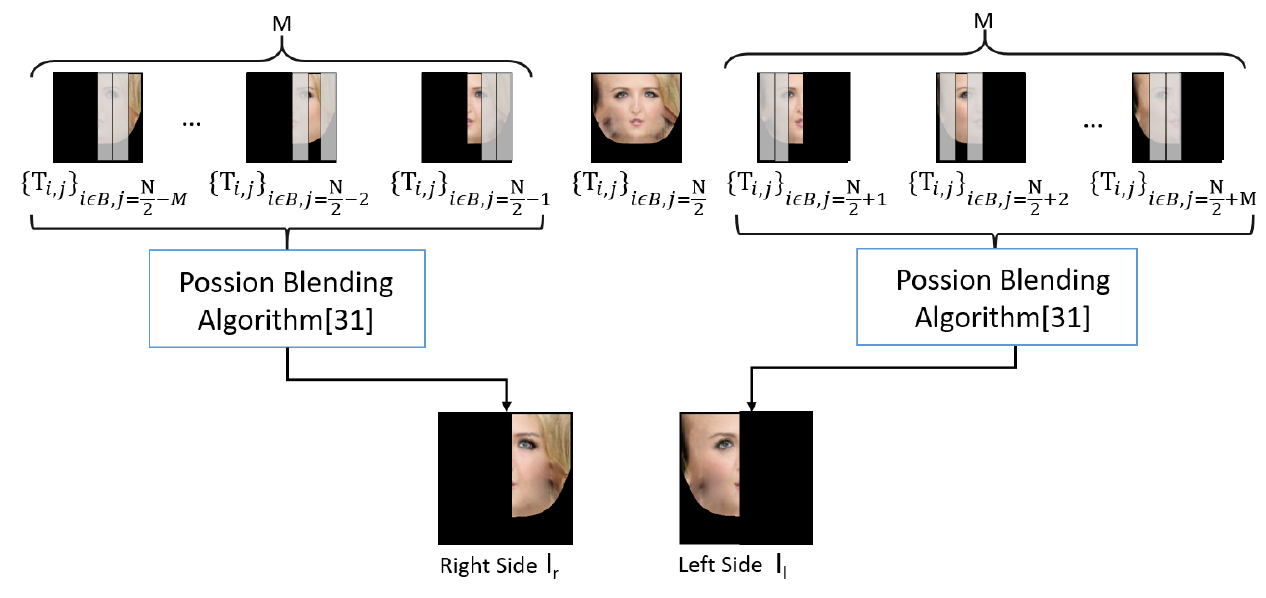
Figure 5. Texture blending calculation method.